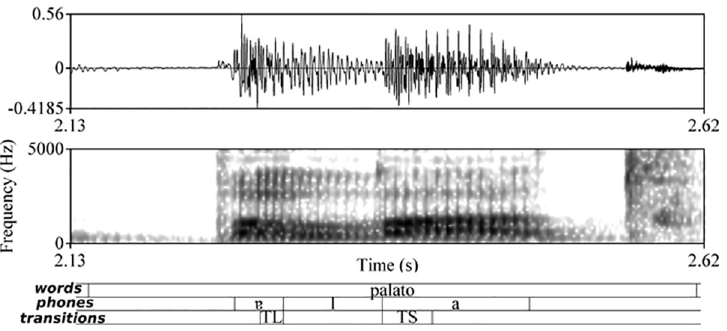
Fig 1. Annotation of the acoustic signal in the word < palato > [p ɐˈ latu] produced by speaker